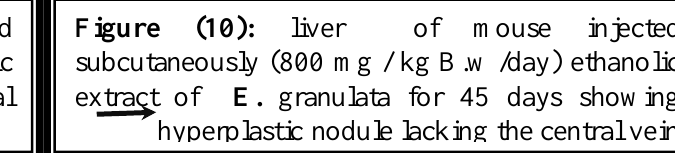
Figure (9) Myocardium of mouse injected Figure (10): liver of mouse injected subcutaneously (800 mg / kg B.w /day) ethanolic subcutaneously (800 mg / kg B.w /day) ethanolic extract of E. granulata for 45 days showing focal extract of E. granulata for 45 days showing aggregation of mononuclear cells hyperplastic nodule lacking the central vein ( ) (H&Ex 400). ( ) (H&Ex400).